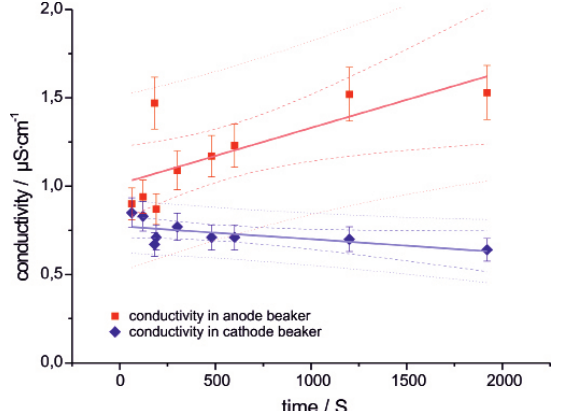
Figure 10. Exp. 2b: Transport of phenol from anodic to cathode beaker, conductivity measurement. The values are evaluated with a linear fit including 95% confidence (dashed) and 95% prediction (dotted)